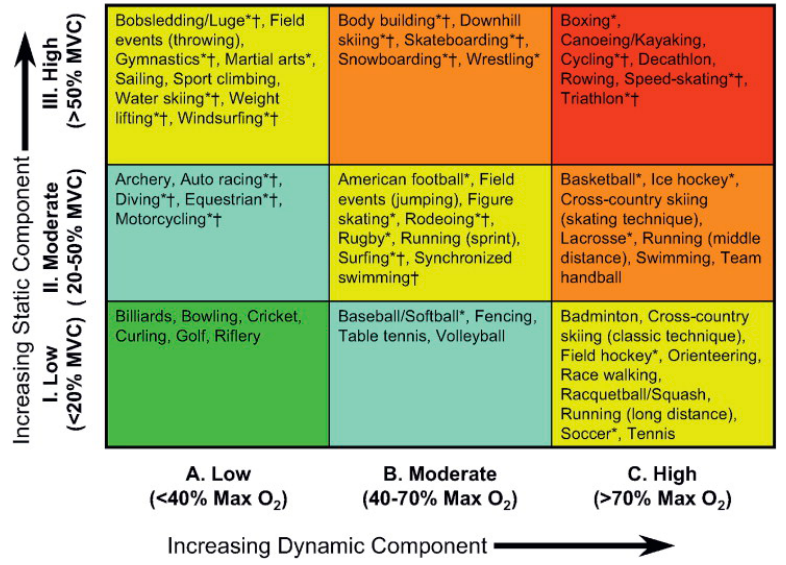
Figure 4. Sports classification model highlighting the combination of static and dynamic characteristics of differing sporting activities. Taken with permission from Mitchell et al., [13].